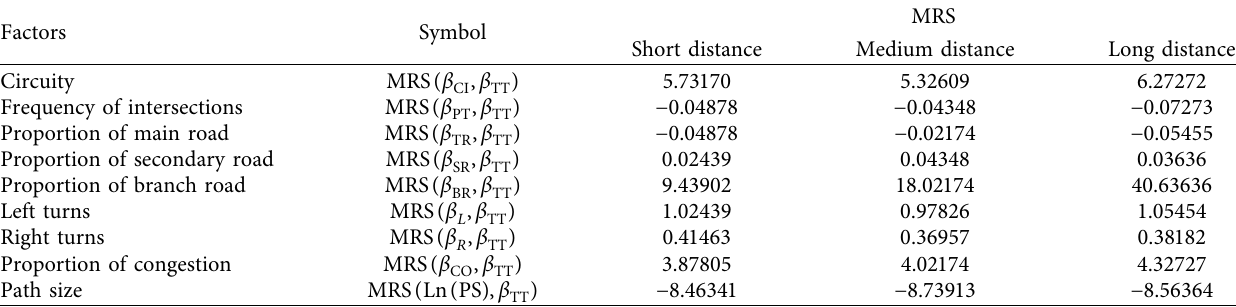
Table 6: MRS of explanatory